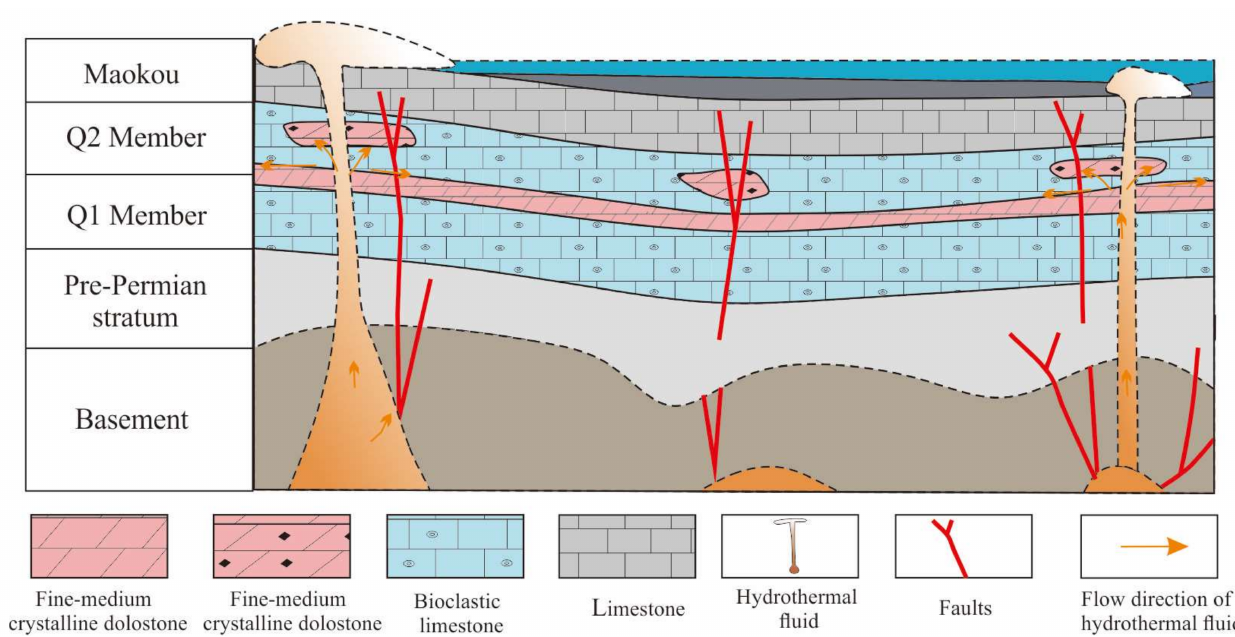
Figure 10. Genetic model of dolostone formation affected by phase II